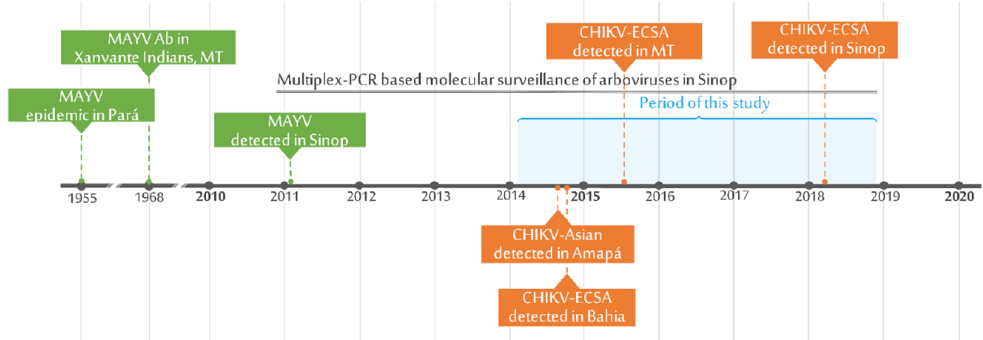
Figure 1. Timepoints of MAYV and CHIKV surveillance/detection in Sinop and nearby areas in the Amazon rainforest and the state of Mato Grosso.